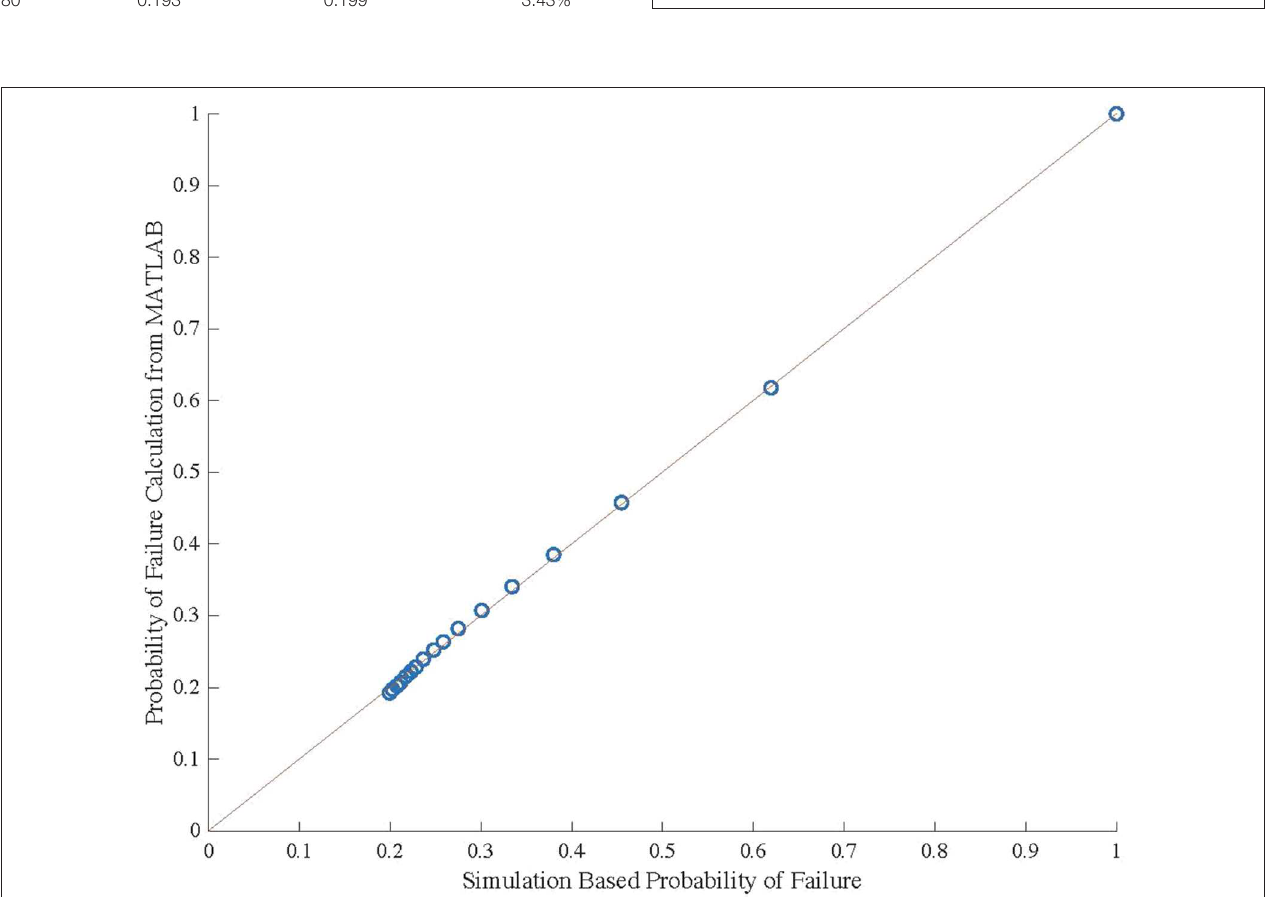
FIGURE 4 | Graphical comparison of probability of failure calculation methods for 0.04 and 0.08 m case.